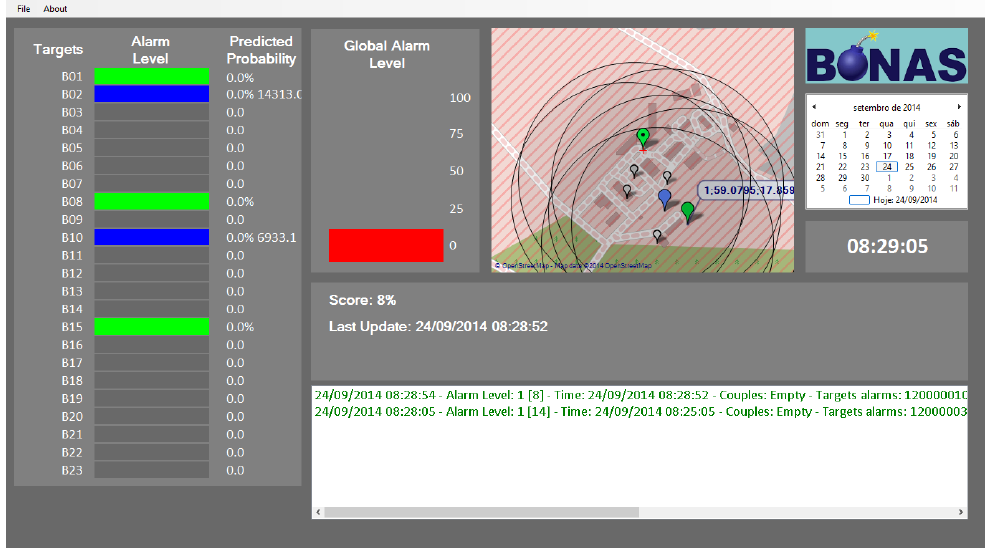
Figure 6. User interface during an experiment performed at FOI, which shows the results for the two possible targets giving positive detection by Lidar.